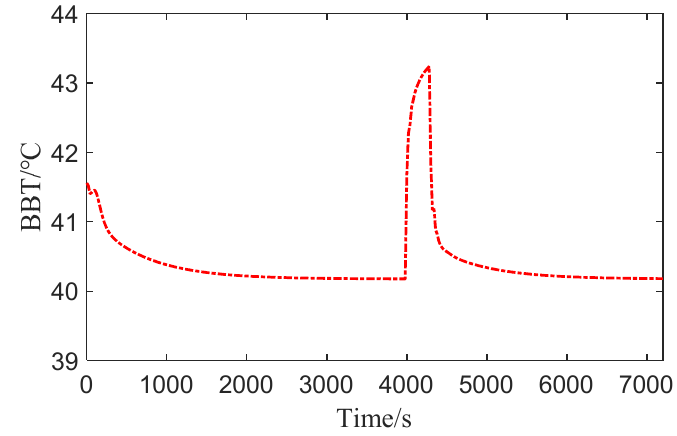
Figure 14. Dynamic of BBT for step increase in T sea